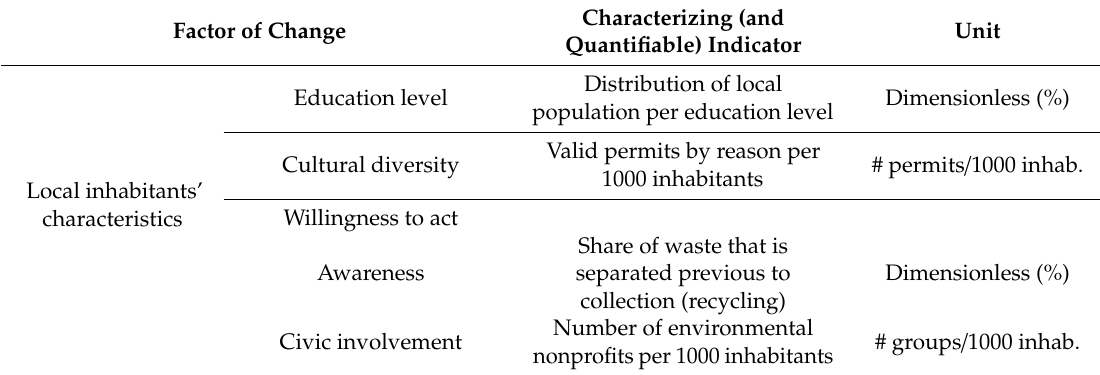
Table 4. Factors of change associated with local context with corresponding indicators.